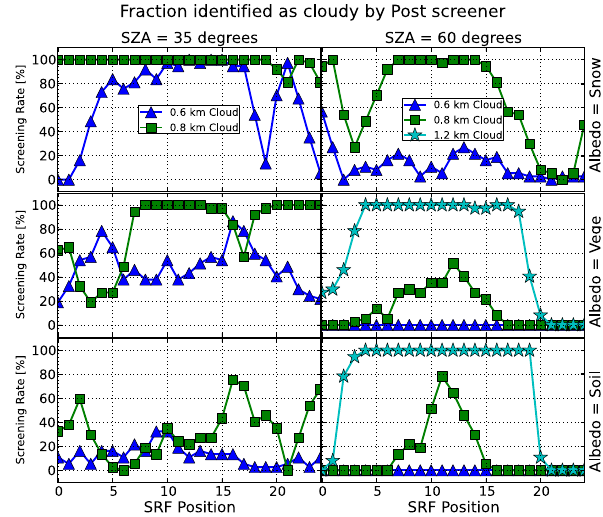
Figure 6. Fraction of simulated spectra identified as cloudy by the post screening